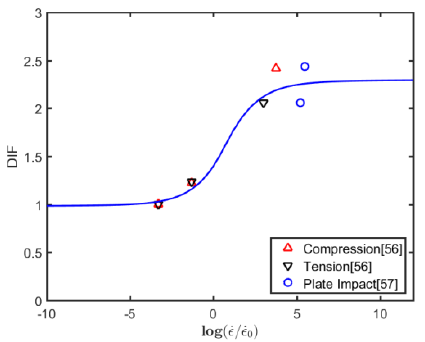
Figure A5. Comparison of the new model (Equation (A4)) with the DIF test data for 93W tungsten alloy.